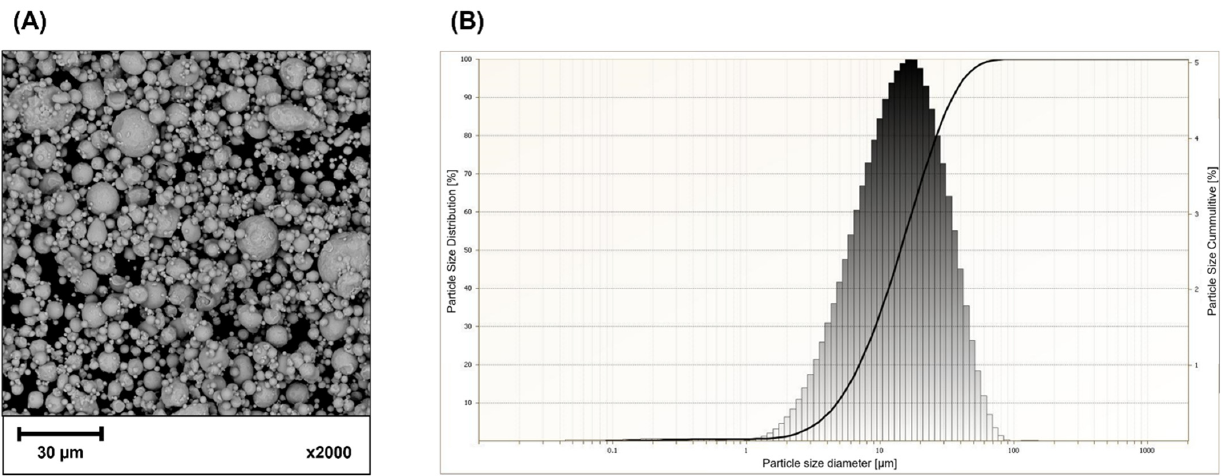
Figure 3. Osprey ® 316L powder characterization: ( A ) SEM morphology, ( B ) particle size distribution analysis. Table 1. Chemical composition of Osprey ® 316L powder [57].